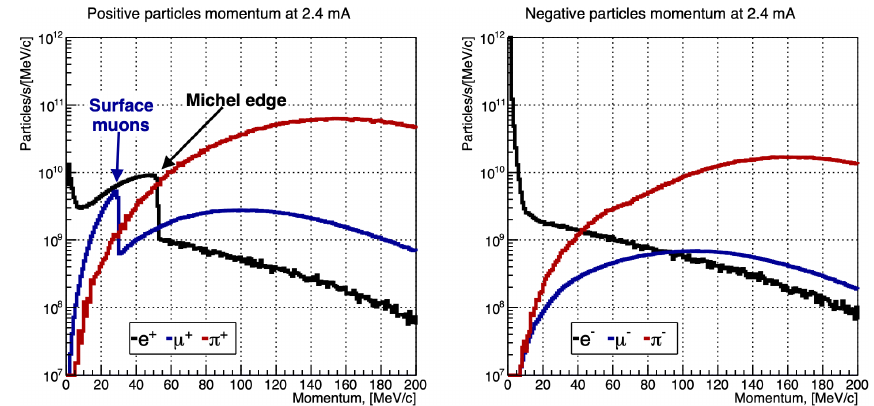
Figure 7. Momentum spectrum of positive (left) and negative (right) particles produced at TgH at a proton current of 2 . 4mA [10].